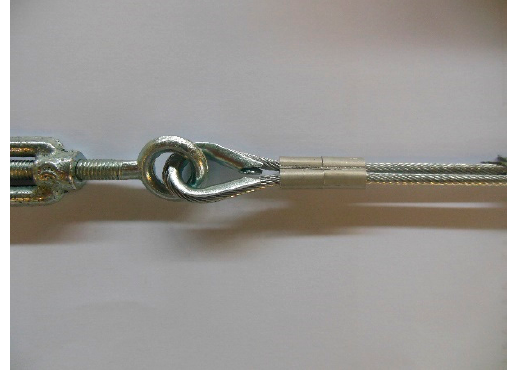
Figure 27. Specimen 2: Flemish eye closed by 2 ferrules. Materials 2019 , 12 , x FOR PEER REVIEW